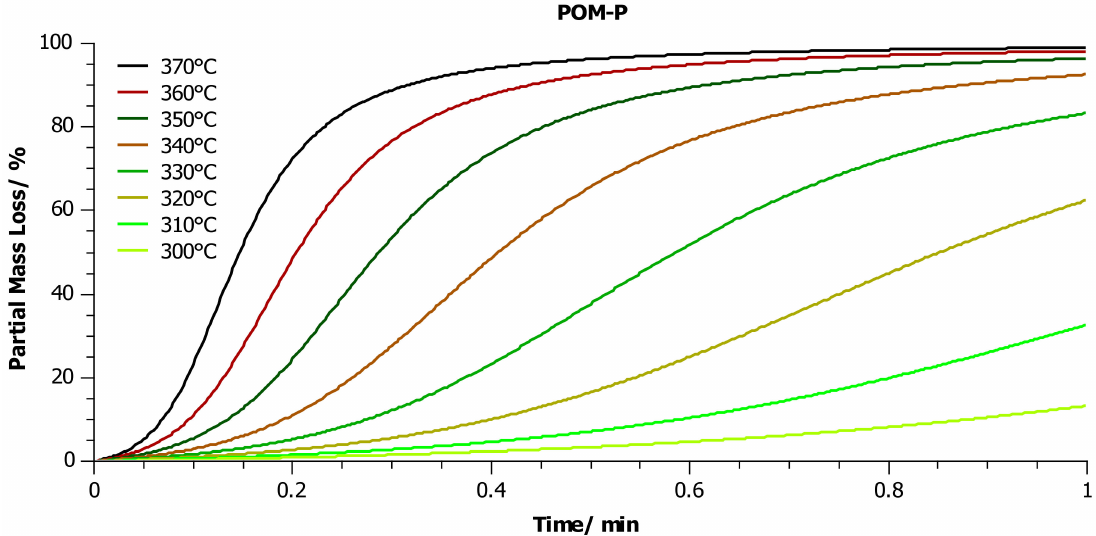
Figure 9. Prediction of the partial mass loss during heating in the temperature range 300–370 ◦ C in an oxygen atmosphere. The simulation was performed for the kinetic model of the POM-P sample, which was characterized by the best fit to the experimental results (Table